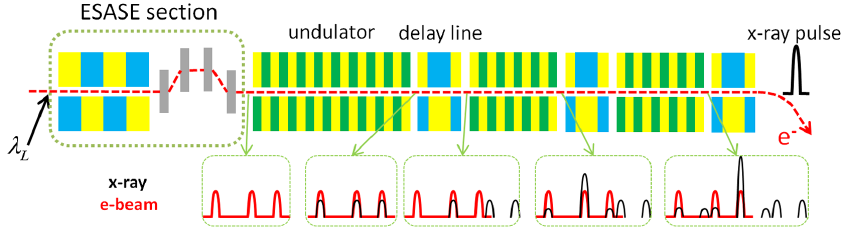
FIG. 1. Schematic layout of the proposed